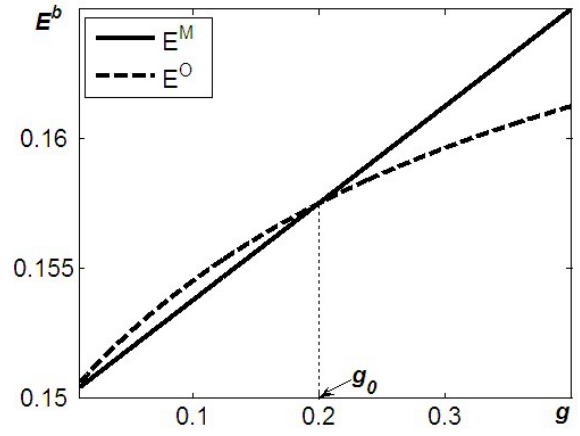
Figure 4. Effect of g on E b